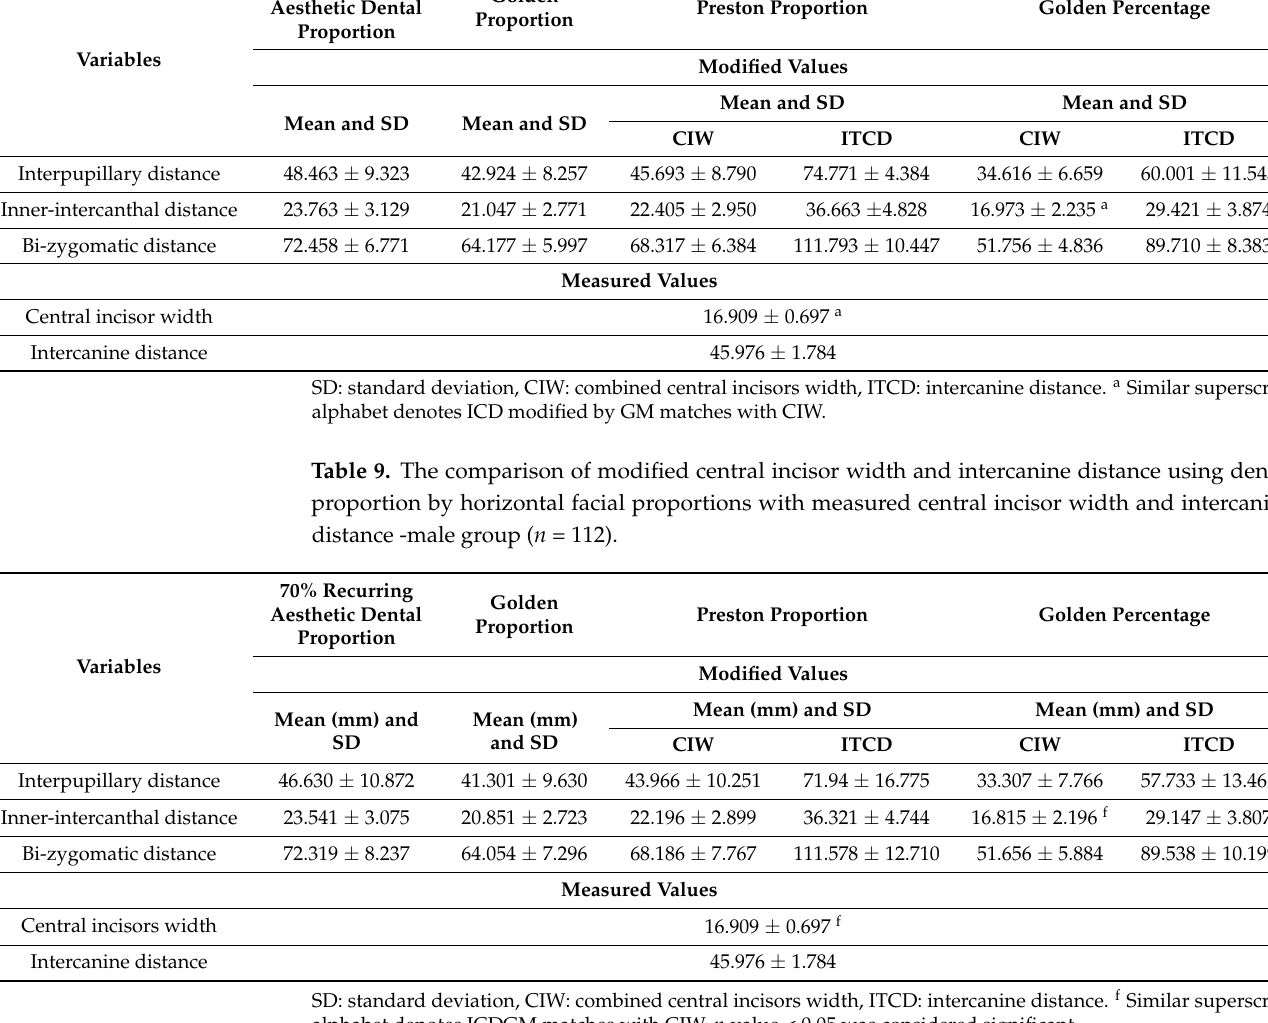
Table 10. The comparison of modified central incisor width and intercanine distance using dental proportions by horizontal facial proportions with measured central incisor width and intercanine distance -female group ( n =